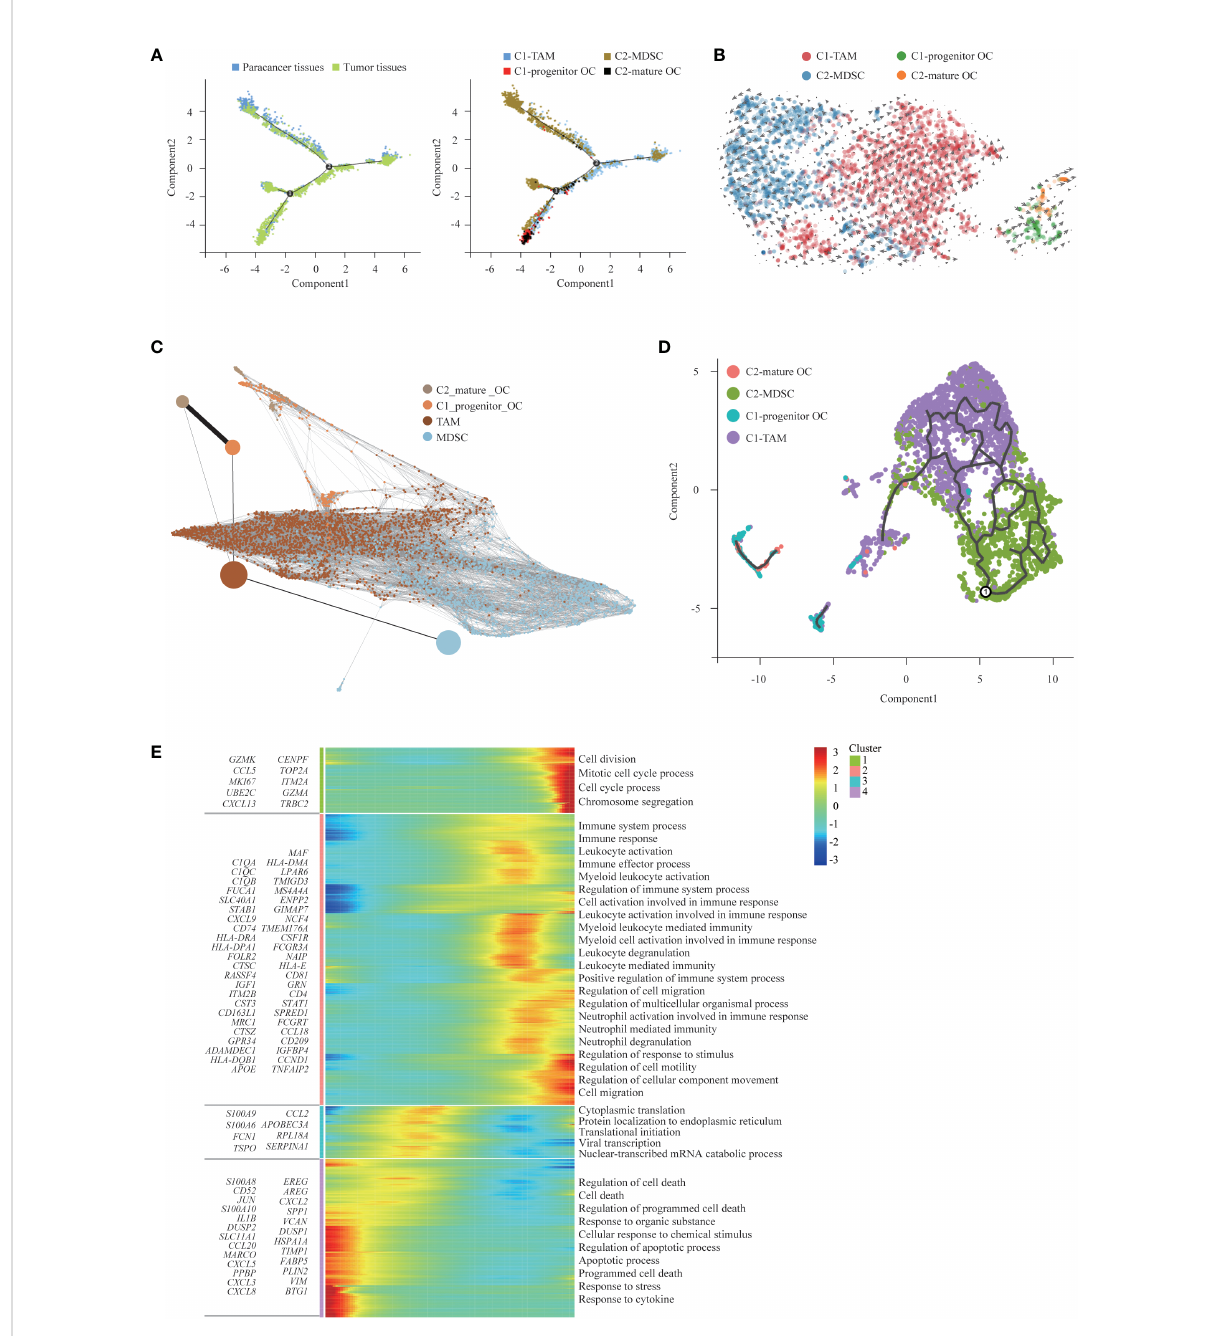
FIGURE 6 The trajectory analysis of osteoclasts and macrophages. (A) Monocle 2 analysis, (B) RNA velocity analysis, (C) PAGA analysis, and (D) Monocle 3 analysis on Osteoclasts and Macrophages phenotypes independently con fi rming the maturation trajectories. (E) The DEGs in Osteoclasts and Macrophages along the pseudotime were hierarchically clustered into different subsets. The top annotated GO terms in each cluster were